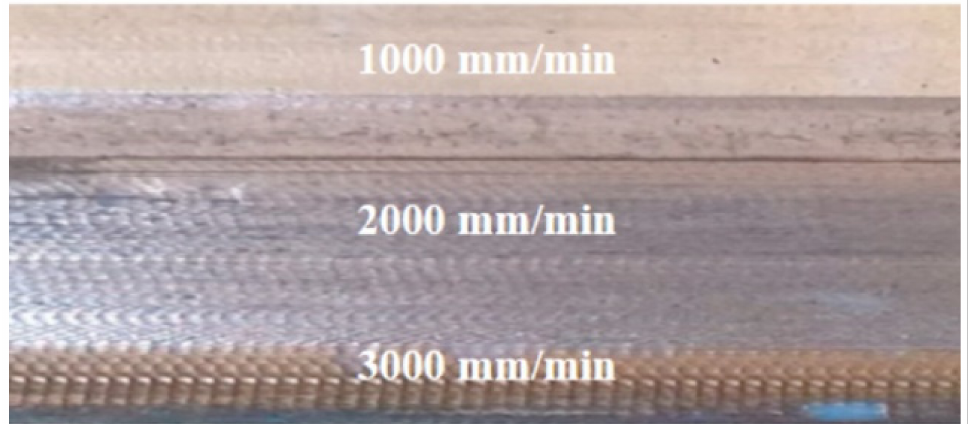
Figure 25. Images showing the effect of the feed rate on the surface quality of the sheet (reproduced with permission from [132]; copyright © 2019 The Author(s). Published by Elsevier